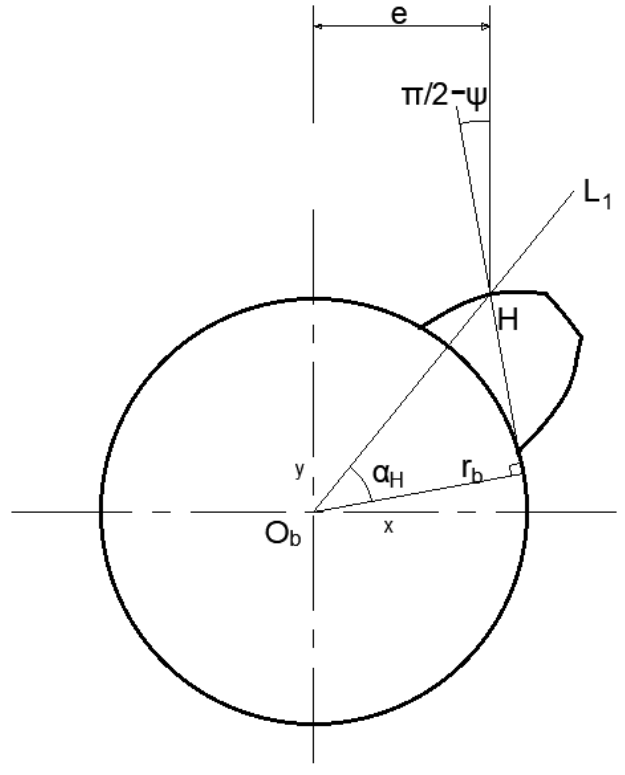
Figure 4. Schematic diagram of the normal of the tooth